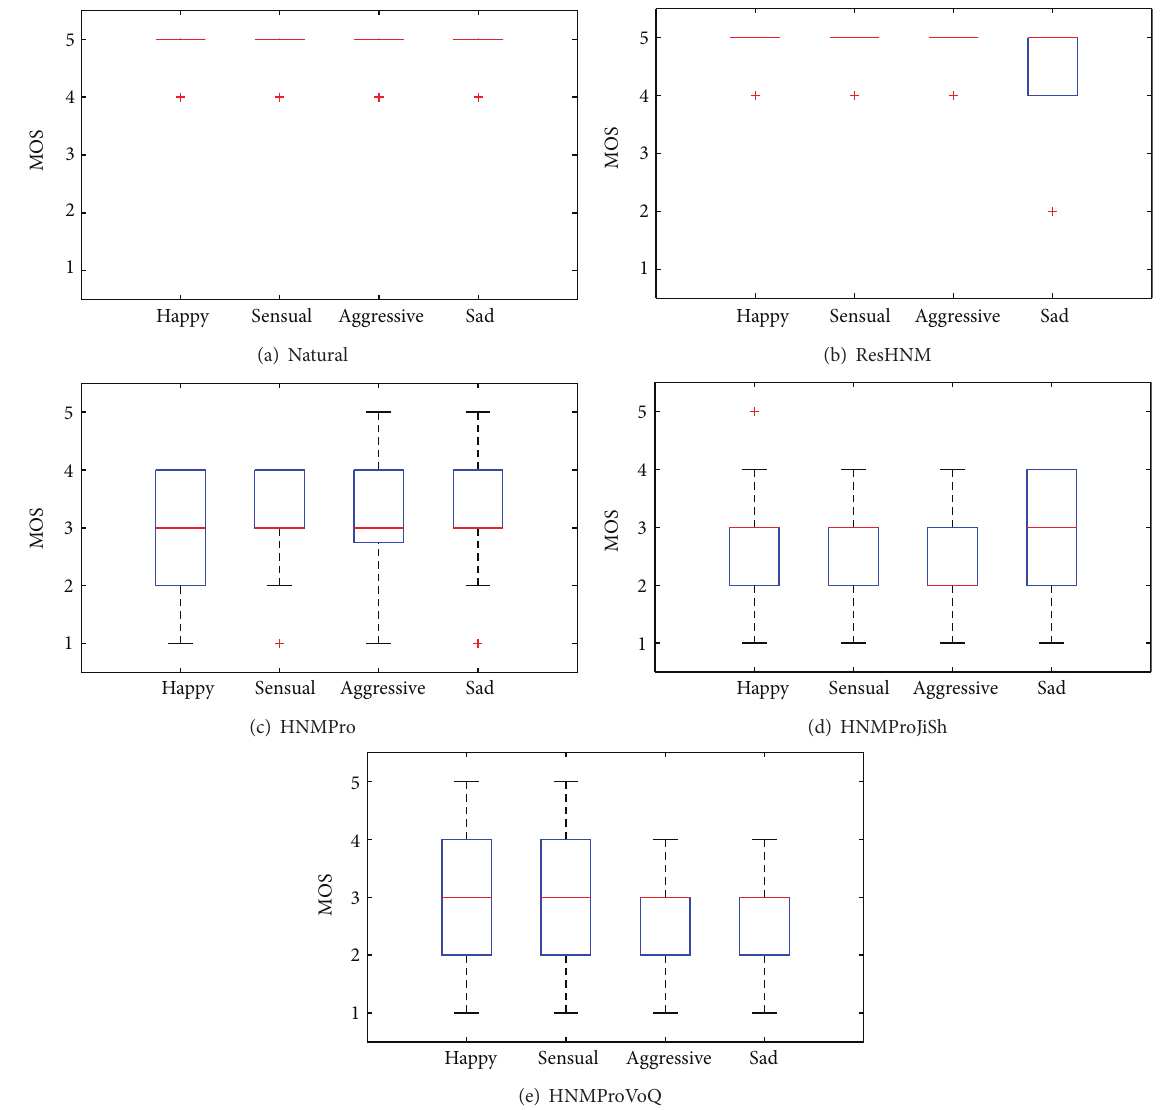
Figure 2: Quality MOS test results for the configurations of “Natural,” “ResHNM,” “HNMPro,” “HNMProJiSh,” and “HNMProVoQ.”